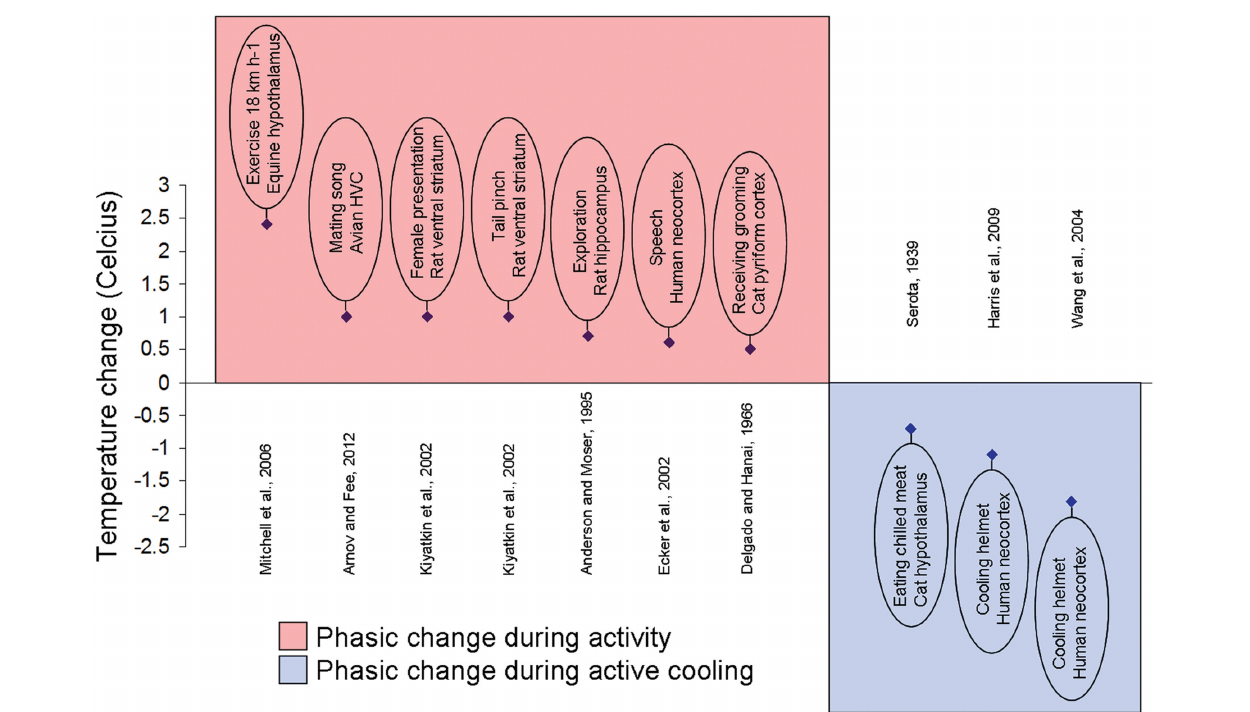
background) or to external cooling (plotted over blue background). Brief experiment description, species, and brain area written inside oval and reference displayed on opposite side of